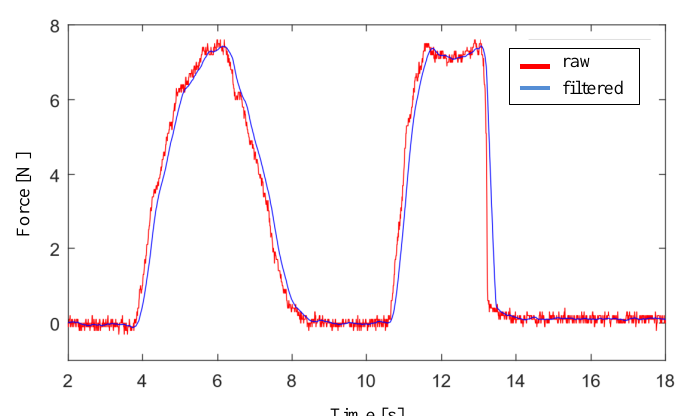
Figure 5. Result of filtering the force signal with a moving average filter with a window size of 32.